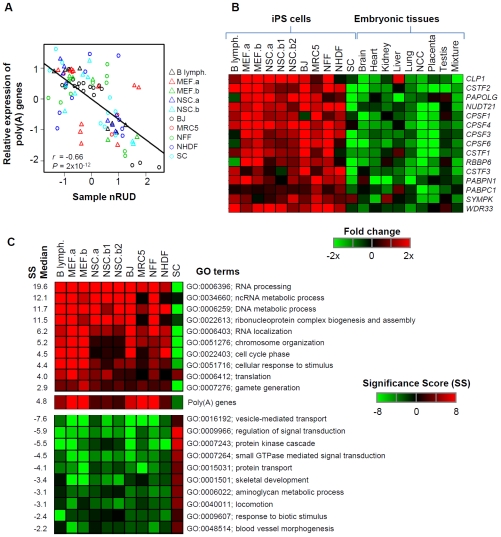
Gene expression analysis in generation of iPS cells.(A) Correlation between mRNA expression of 94 poly(A) genes and nRUD values for all cell types, including before and after reprogramming and partially reprogrammed cells. Poly(A) genes are those reported in [21] plus gene encoding Clp1 (see Table S3 for the complete list). (B) A list of genes encoding core polyadenylation factors that are consistently regulated in generation of iPS cells. Fold changes (ratio of after reprogramming to before reprogramming) are shown in a heatmap according to the color scale shown at the bottom. Only the genes with consistent trend of regulation, either upregulation or downregulation in >9 out of 10 data sets, during reprogramming of somatic cells are shown. Data for SC and different tissues in embryonic development are also shown for comparison. Human gene symbols are used to annotate genes. (C) Gene Ontology (GO) terms that are significantly associated with genes upregulated (top) and downregulated (bottom) during generation of human and mouse iPS cells from somatic cells. Significance score (SS) is used to represent P-values (see Methods for detail), and is shown in a heatmap according to the scale shown in the graph. The poly(A) gene group was also analyzed and is shown in the middle. Its P-values are <0.01 for all cell types. The median SS based on reprogramming of somatic cells is listed and used to sort GO terms. GO terms associated with more than 1,500 genes are considered too generic and are discarded. To eliminate redundancy, we require that the reported GO terms do not overlap with any other GO term with greater SS by more than 25% of associated genes.